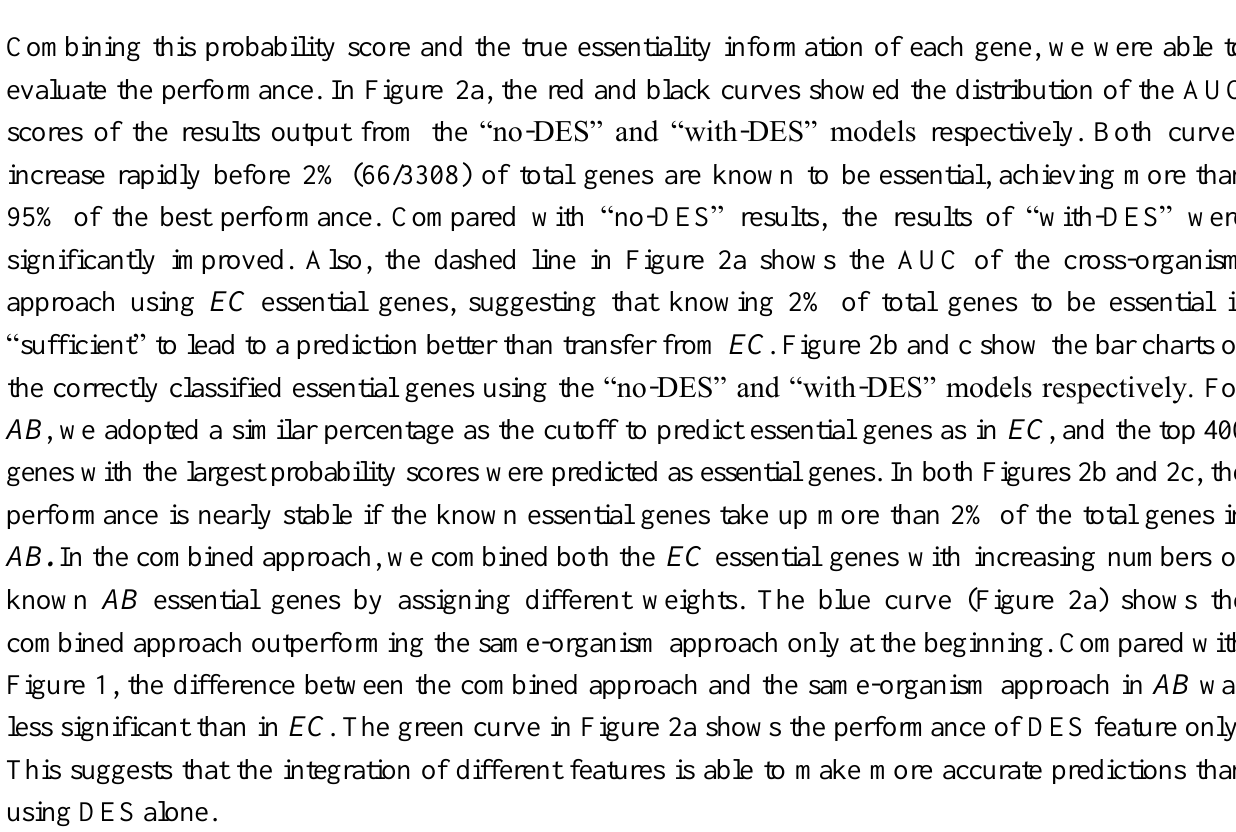
Figure 2. Comparison of three approaches in AB. ( a ) The distribution of AUC along with the different sizes of known essential genes in AB : red curve: same-organism approach “with no-DES”; black curve: same-organism approach “with DES”; blue curve: combined approach; dashed line: cross-organism approach. The bar chart of the correctly classified essential genes among the top 400 predictions with respect to the different sizes of known essential genes in AB using ( b ) “no-DES” model; ( c ) “with-DES” model; and ( d ) combined model. The black bar shows the correctly classified essential genes in the “gold standard”